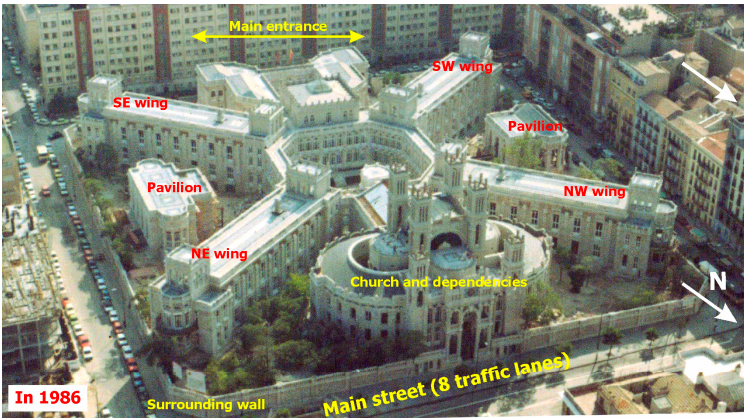
Figure 1. Aerial view of the former hospital ca. 1986, showing the overall layout: church, main entrance, diagonal wings and free-standing pavilions. Enclosed inside a surrounding wall, the compound is bounded by four streets, with very heavy traffic on the one bordering the church portal (courtesy of the Land Management).